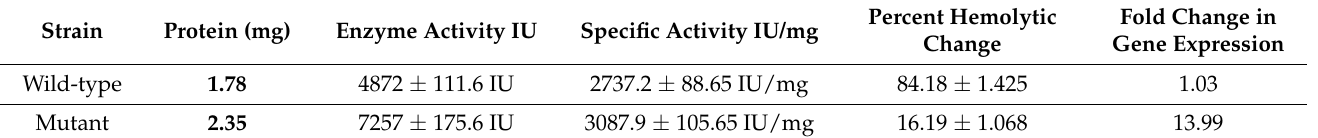
Table 1. Summary of streptokinase expression in wild-type and mutant strains of S. equisimilis .